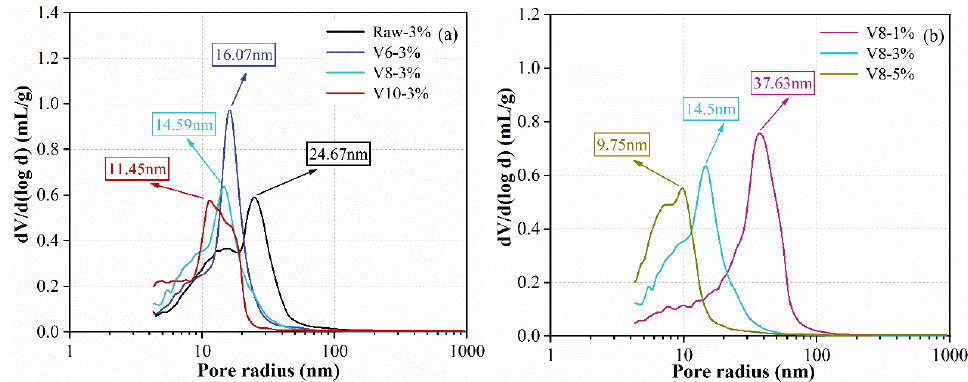
Figure 11. The pore-size distribution of hardened specimens at 28 d: effect of BFS fineness ( a ) and effect of NC dosage ( b ).